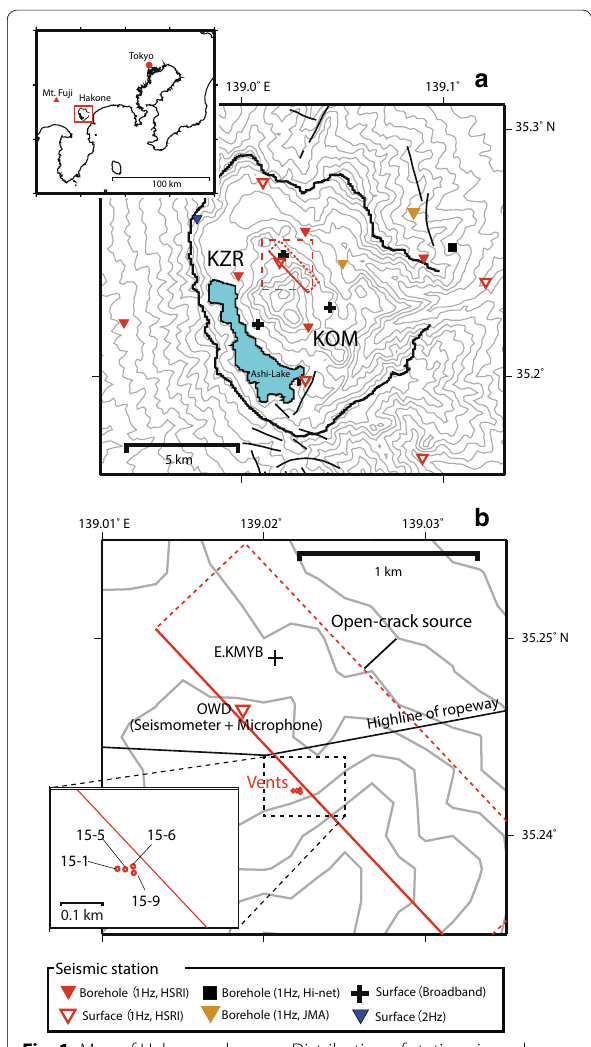
Fig. 1 Map of Hakone volcano. a Distribution of stations in and around the caldera of the Hakone volcano. The study region is indi- cated by the red rectangle in the inset map. The bold line shows the caldera rim of the Hakone volcano. Gray lines indicate the detailed topography of the Hakone volcano. The red broken rectangle repre- sents the location of the open crack as determined by Honda et al. (2017). b Magnified maps of the Owakudani geothermal region. The red circles depict the locations of the vents that formed during the phreatic eruption (Mannen et al. 2015). The numbers in the inset map indicate the index numbers of the vents defined in Mannen et